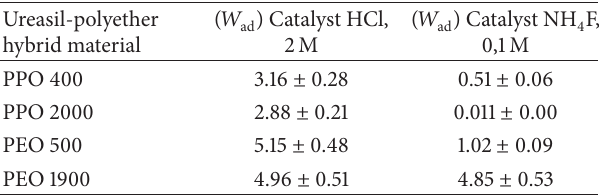
Table 1: Values of work of adhesion ( 𝑊 polyether materials, produced with catalysts HCl and NH are expressed as the mean ± SD for 𝑛 = 5 (replicates).